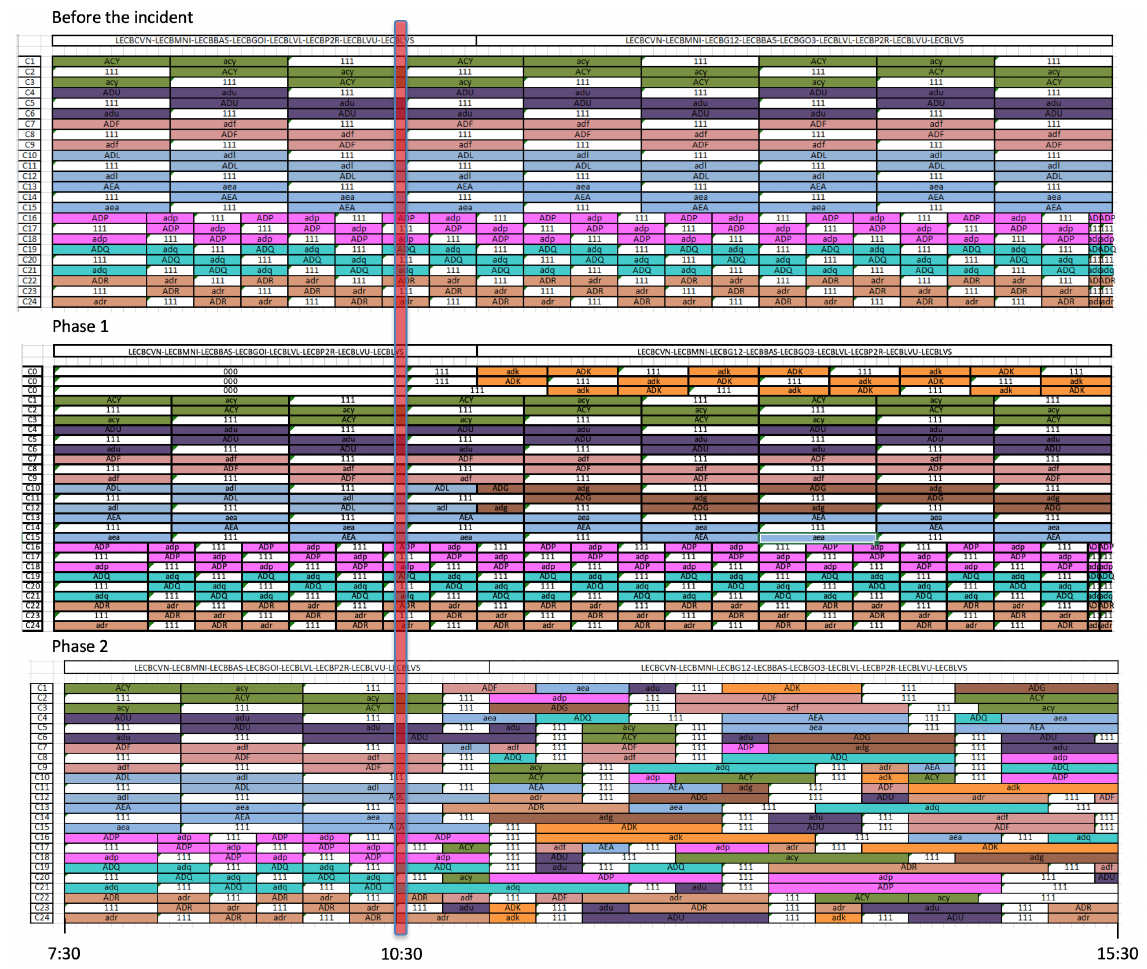
Figure 13. Solution before the incident, solution derived in Phase 1 and solution for Instance